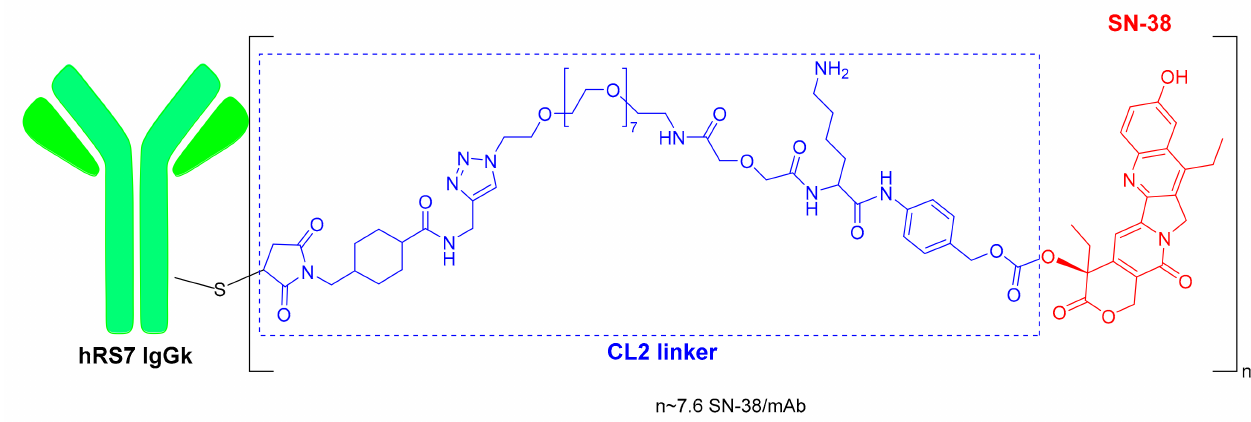
Figure 3. Structure of sacituzumab